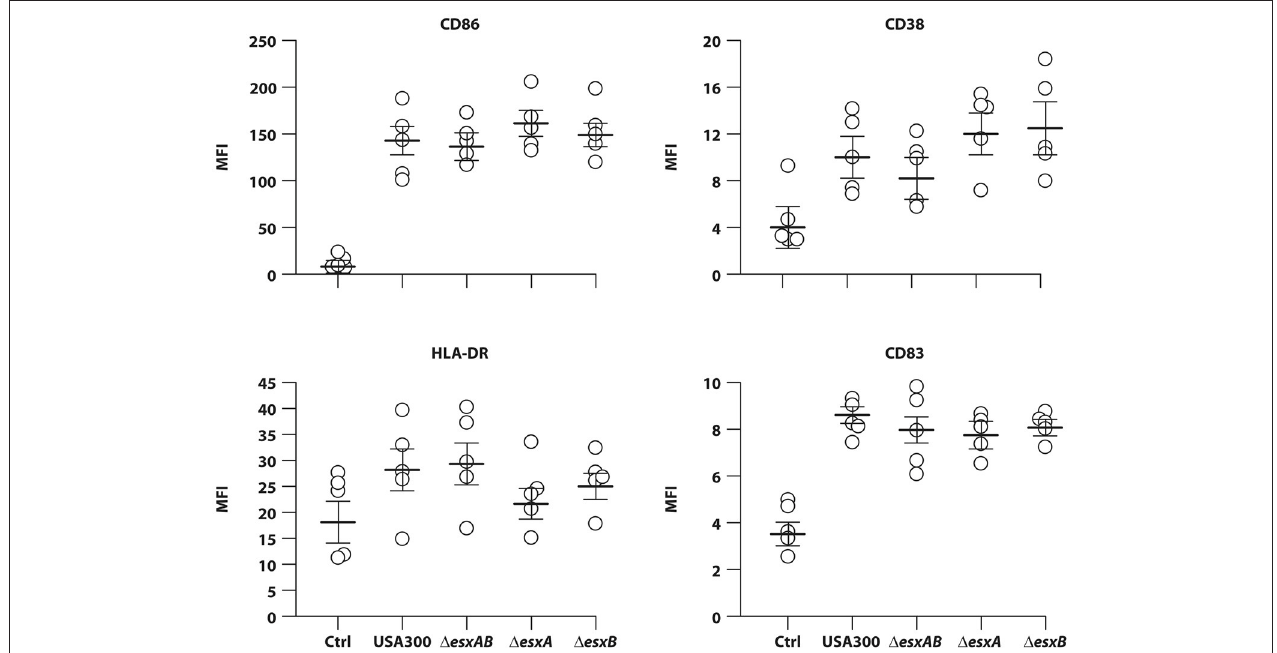
FIGURE 2 | DC maturation in response to infection with wild type USA300 or 1 esxAB , 1 esxA, and 1 esxB mutants. DC were left untreated (Ctrl) or infected for 24 h with wild type USA300 or with USA300 mutants deleted in the esx factors. Surface expression of CD86, CD38, HLA-DR, and CD83 was examined by cytometric analysis in 5 independent experiments and graphed by calculating the mean fluorescence intensity (MFI) after the subtraction of the isotype Ab controls. MFI values for each individual experiment and mean MFI ± SEM are